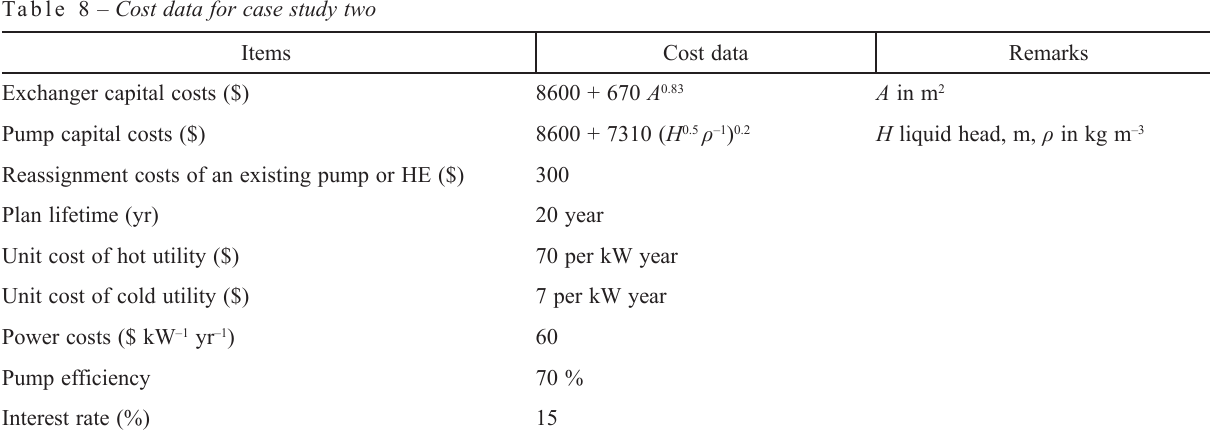
Table 8 – Cost data for case study two